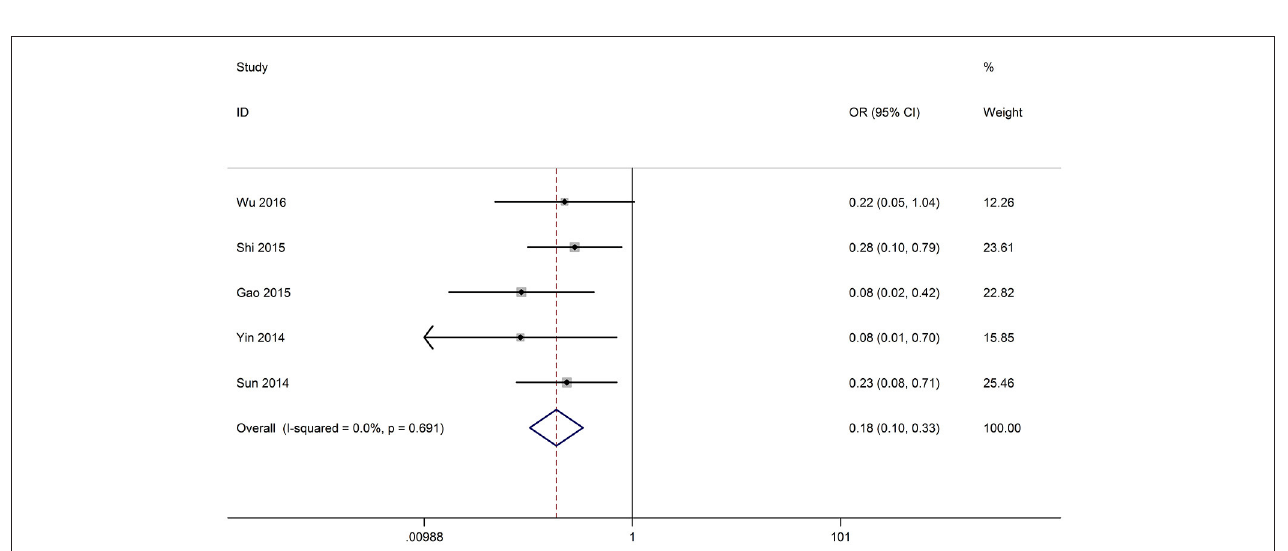
Frontiers in Physiology |